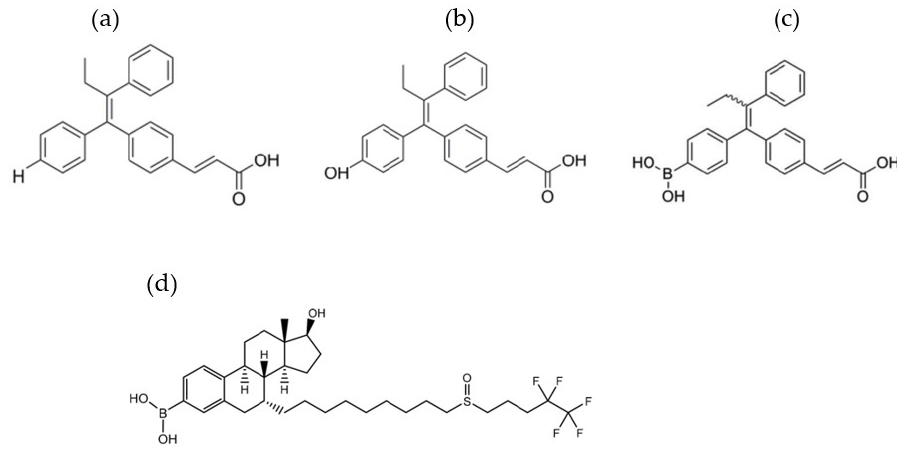
Figure 2. The chemical structure of: ( a ) GW5638; ( b ) GW7604; ( c ) GLL398; and ( d ) ZB716. Table 1. The binding affinity of boronic-derivative SERD candidates.